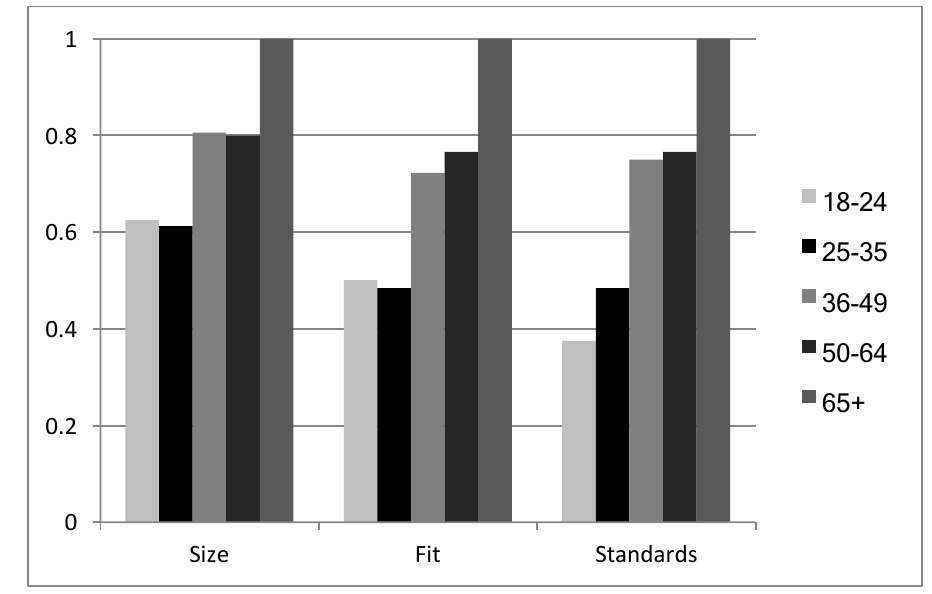
Figure 1 . Proportion of Age Group Reporting “Sometimes” or “Routinely” to Indicated Questions Despite varying degrees of reported difficulty, many of the specific complaints are similar across the age spectrum and reflect the need for clothing and apparel that both accommodate disability-related needs and are stylish and age-appropriate. For example, disabilities often result in atypical body sizes or proportions, leading to difficulty with finding appropriately fitting apparel items (Garner and Douglas 1991; Wang et al. 2014). Representative comments demonstrate these difficulties are shared and persistent across different age groups (Table 3). Another common problem for members of multiple age groups is difficulty with